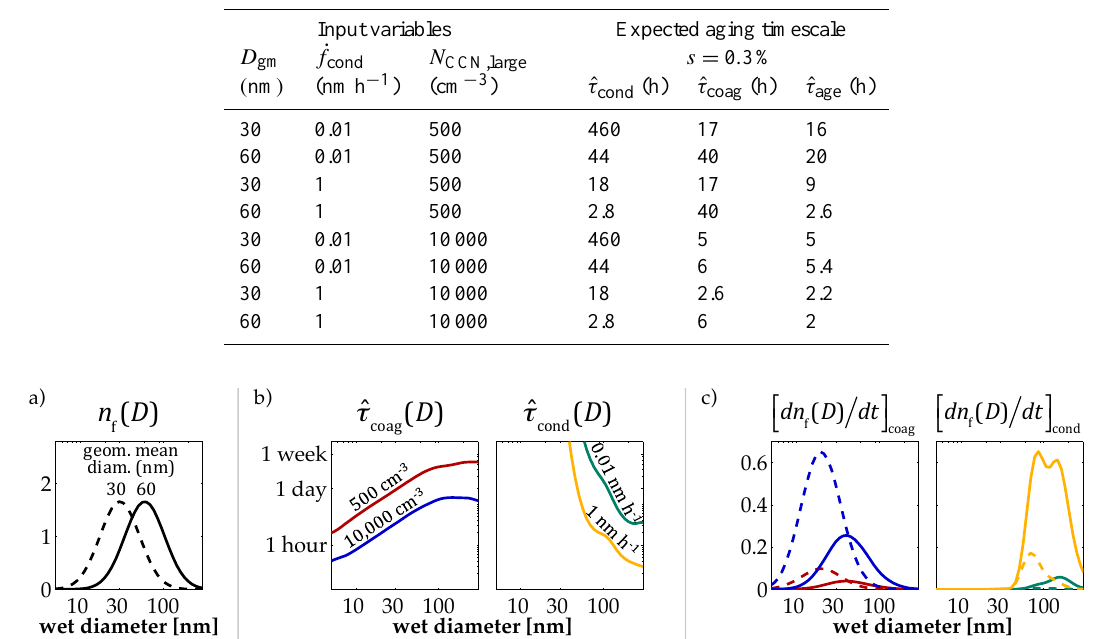
Table 6. Bulk aging timescale for two fresh particle size distributions under different aging regimes. Condensation, coagulation, and overall aging timescales are given for s = 0 . 3%. We assumed lognormal size distributions of fresh BC with a geometric standard deviation of 1.7.